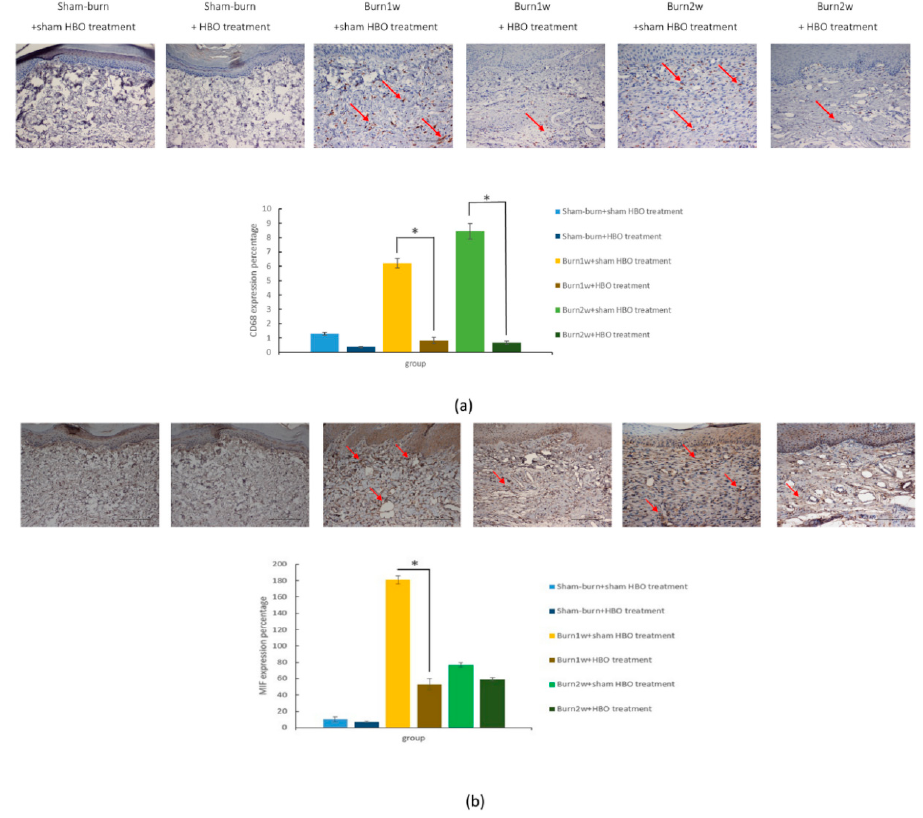
Figure 4. ( a , b ) HBO treatment decreased CD68 and macrophage migration inhibitory factor (MIF) expression. Immunohistochemistry (IHC) analyses of CD68 and macrophage migration inhibitory factor (MIF) in hind paw skin histologic specimens at one and two weeks after burn injury. CD68 expression decreased significantly in the burn with HBO treatment group compared with the burn with sham HBO treatment group. MIF expression decreased significantly in the burn with one-week HBO treatment group compared with the burn with one-week sham HBO treatment group. * p < 0.05, original magnification: × 20. The arrows indicate nuclei with CD68 and MIF